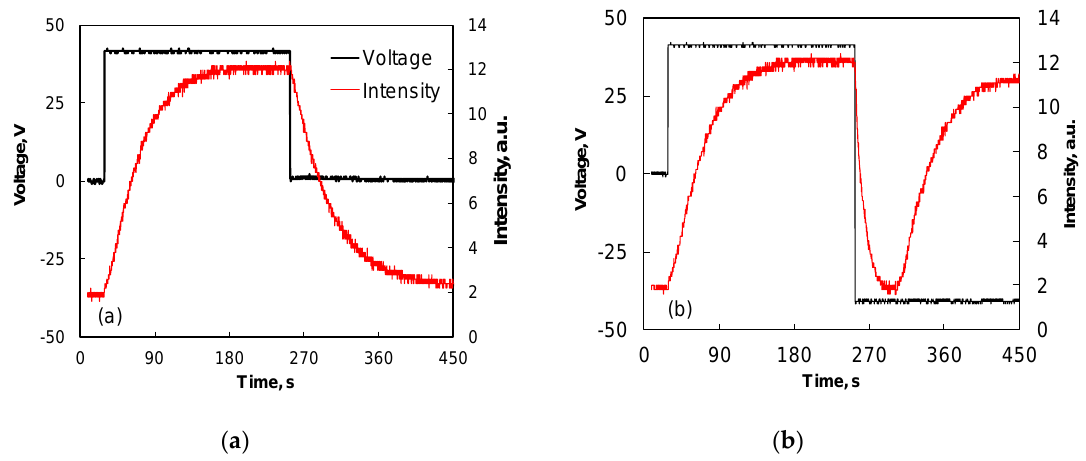
Figure 10. Time-dependent light intensity change actuated by ( a ) +40-V pulse voltage and ( b ) ±40-V pulse voltage. The data was adapted from ref. [30] with permission.